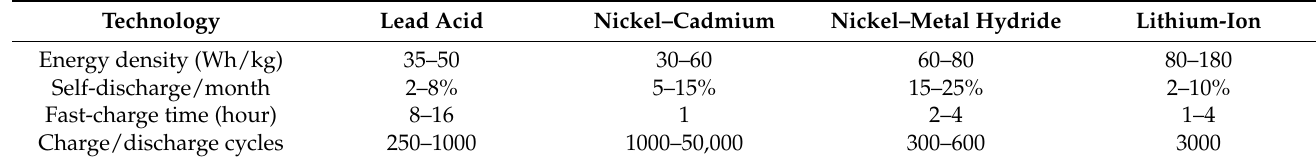
Table 3. Characteristics of rechargeable